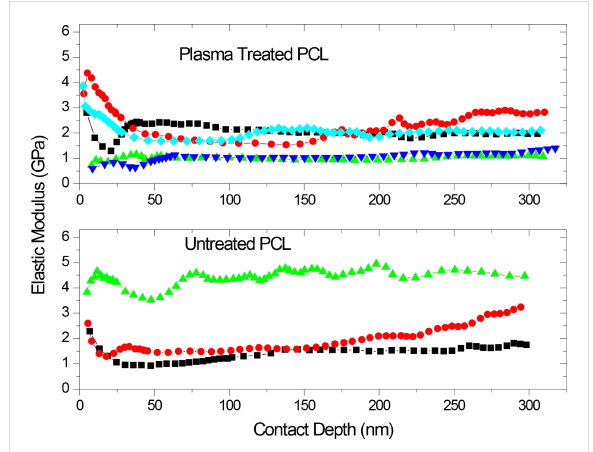
Figure 3: The elastic modulus values of the untreated PCL electro- spun scaffolds and the plasma-modified ones (20 W) versus the contact depth. Every curve comes from a nanoindentation measure- ment to a different surface location of the